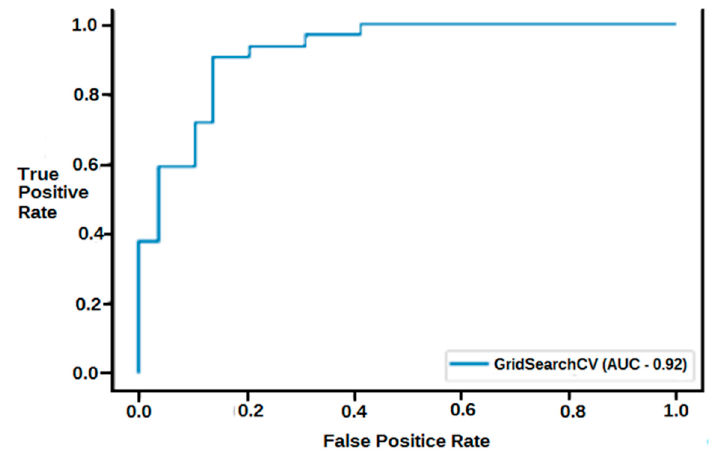
Figure 10. Receiver operating characteristic curve for the logistic regression model. The confusion matrix compares where the model, based on logistic regression, made the right predictions and where it made wrong predictions (Figure 11).